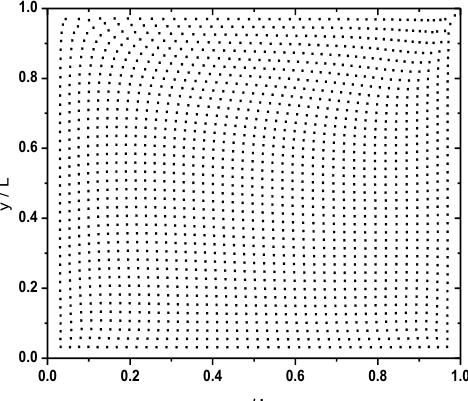
Fig. 5. Particle distributions for new boundary